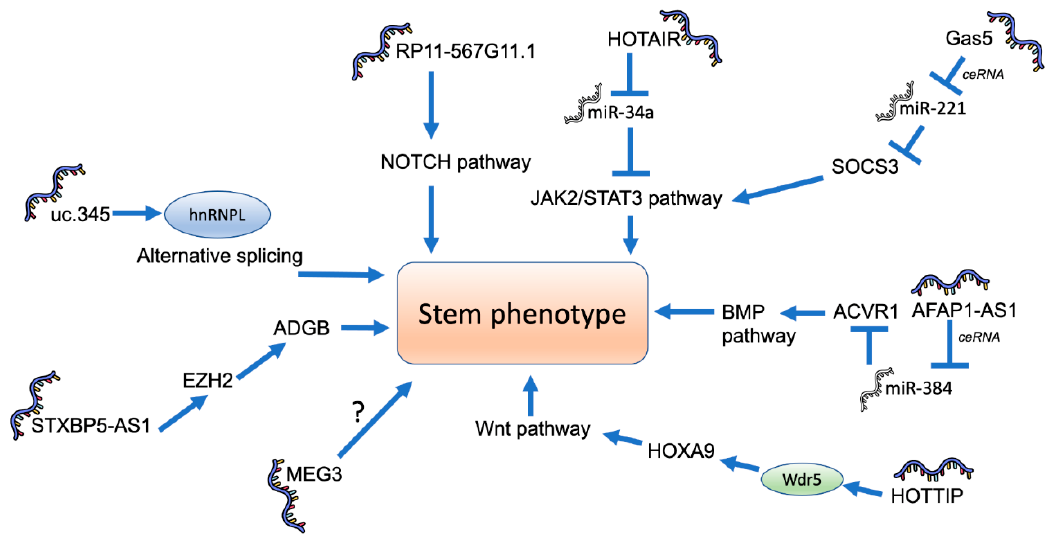
Figure 3. Several lncRNAs modulate the stem phenotype of pancreatic cancer stem cells by an indirect effect on stem factors such as Nanog, Myc, Sox2, Oct4, etc. This indirect mechanism involves various signaling pathways previously associated with stemness. Nevertheless, most of final stages that connect these pathways with the stem factors are currently unknown.